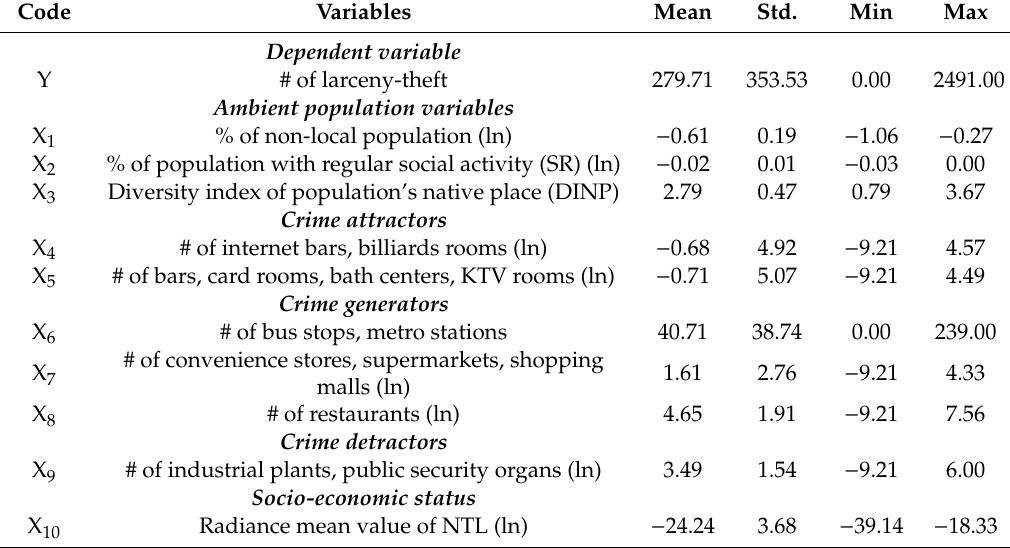
Table 1. Descriptivestatisticsforvariablesusedintheanalysis(N = 187observations). NTL,nighttimelights.